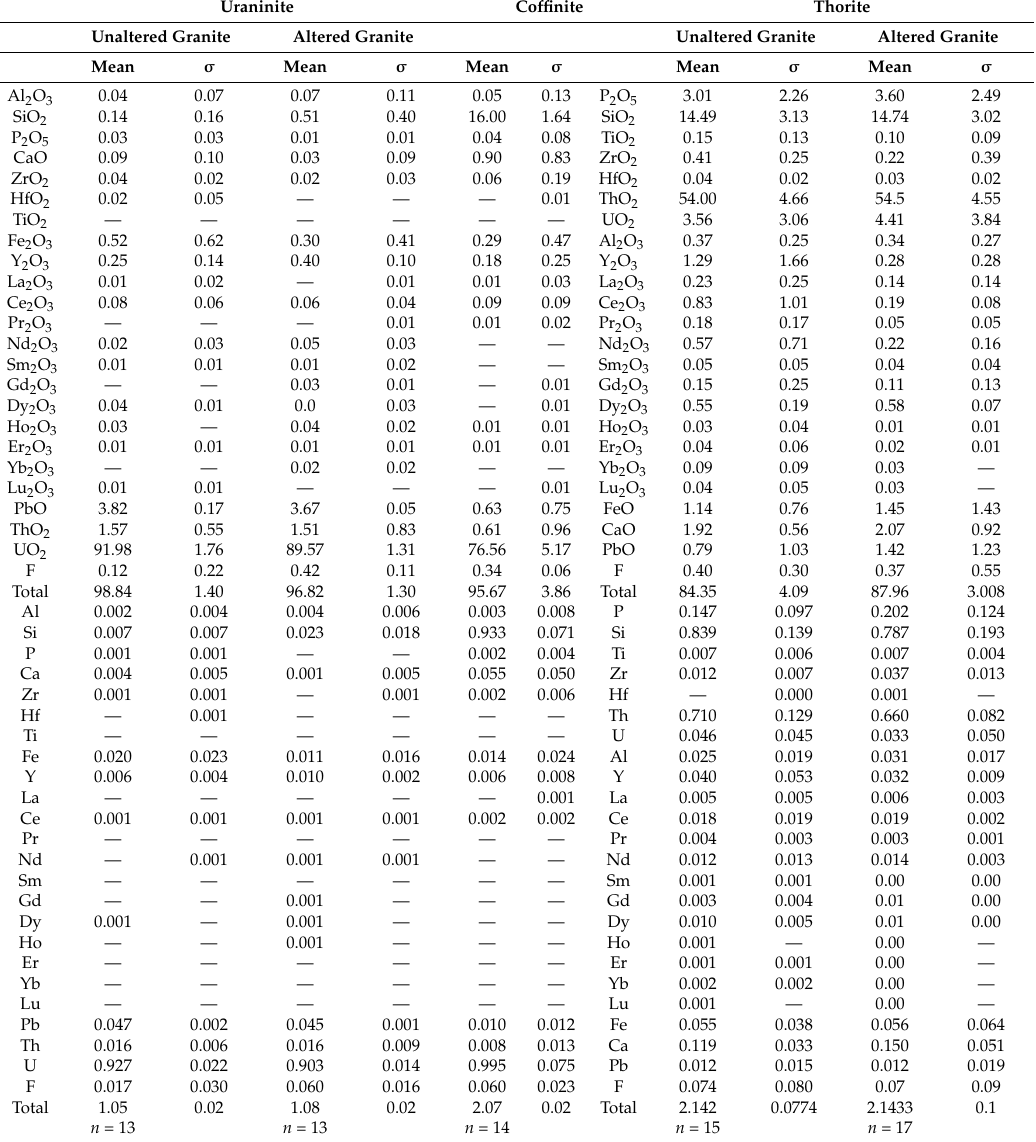
Table 1. Chemical compositions (in weight percent) and structural formula of uraninite, coffinite, and thorite from the unaltered and altered Variscan granites, Central Portugal. Uraninite Coffinite Thorite Unaltered Granite Altered Granite Unaltered Granite Altered